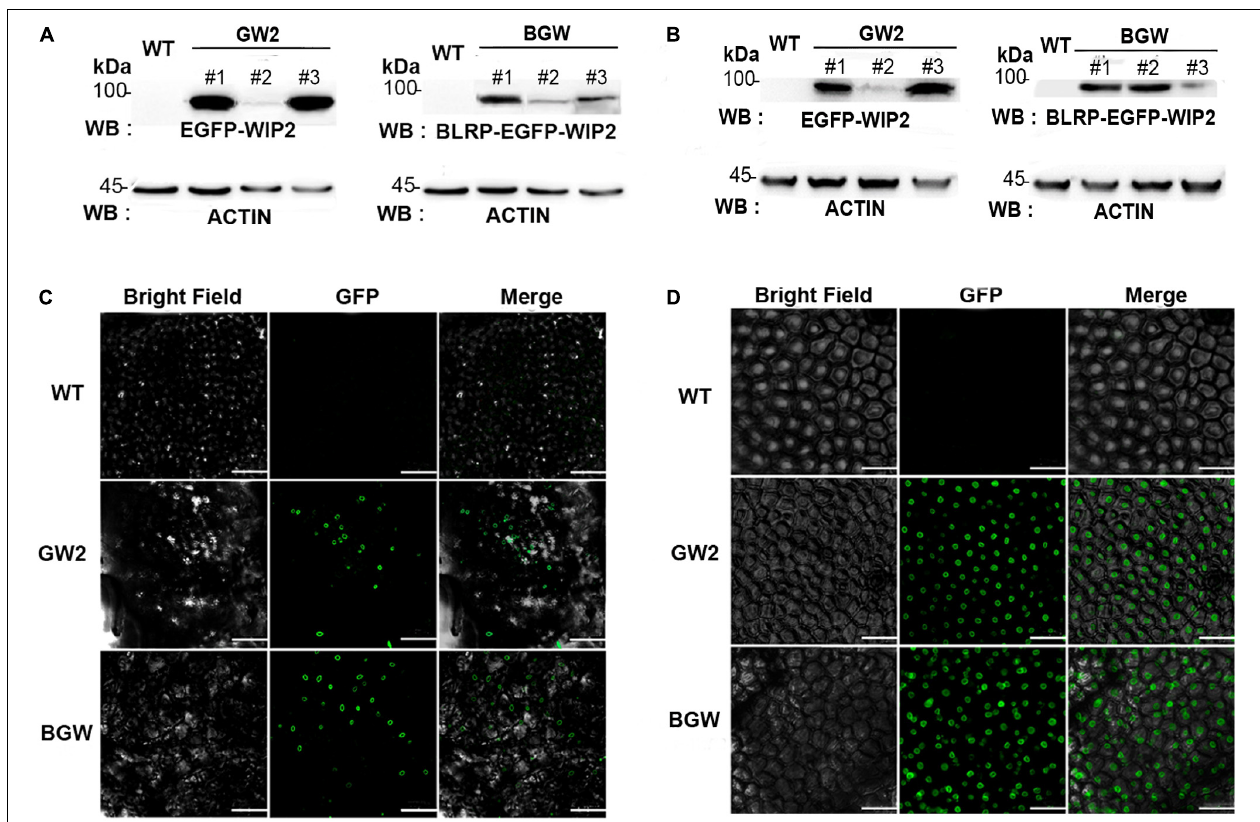
FIGURE 3 | Detection of three Sl NTF proteins in different tomato tissues. Western blotting (WB) was performed with anti-eGFP polyclonal antibody in leaves (A) and fruits (B) , respectively. ACTIN protein is used as a quantitative control. Microscopy images of GFP fluorescence in leaves (C) and fruits (D) showed that both GW2 and BGW are located in the outer nuclear membrane. Scale bars: C, 50 µ m; D, 100 µ